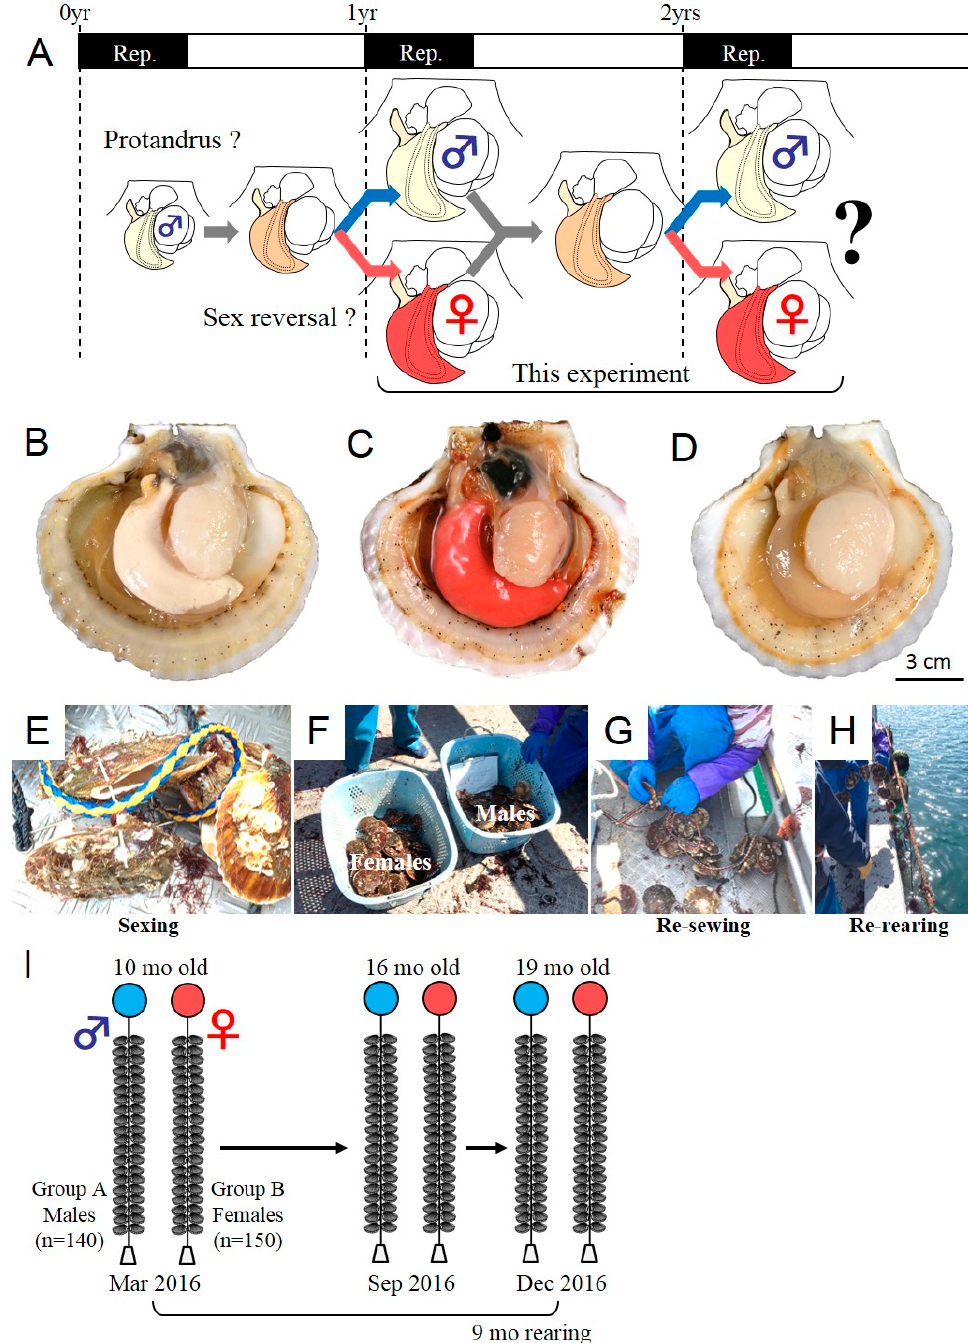
Figure 1. Overview of the analysis of phenotypic stability of sex in the adult Yesso scallop. ( A ) Diagrammatic illustration of sex di ff erentiation in the Yesso scallop. The present study focused on the stage of sex di ff erentiation from 1 to 2 years of age. ( B–D ) Representative dissection images of adult scallops at two years of age. In the reproductive (Rep) phase, males exhibit a milky-colored gonad ( B ), whereas females have an orange / red-colored gonad ( C ). In the non-reproductive phase, the sex is not distinguishable by observation of gonad color ( D ). Hence, sexing was performed during the reproductive period. ( E–I ) Tracking experiment for the analysis of phenotypic stability of sex. ( E ) Sexing was performed by checking gonad color. ( F ) Males and females were divided into two groups. ( G–I ) Each sex group was reattached to di ff erent rearing ropes ( G ) and reared again for extra nine months until the next reproductive period ( H,I ).